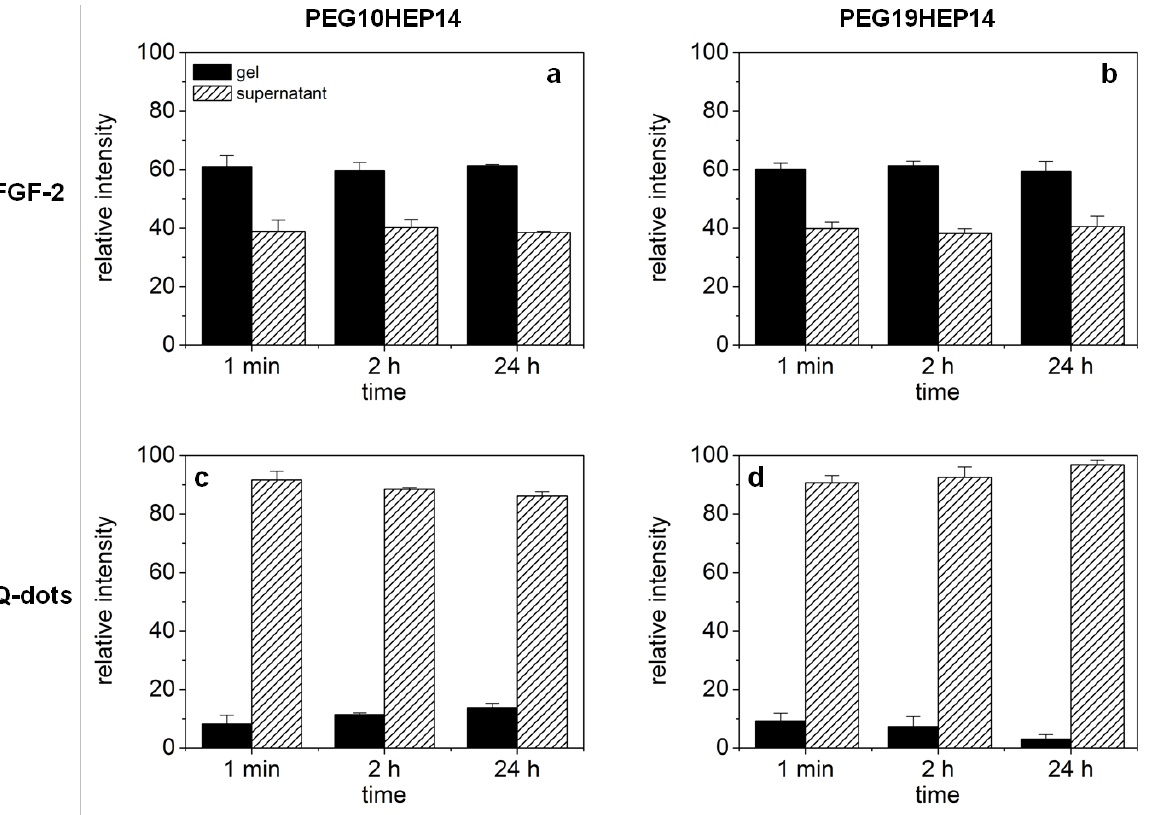
Figure 4. Average fluorescence intensity of TAMRA-labeled FGF-2 (top) and non targeted quantum dots (bottom) in supernatant (solution) and in the starPEG-heparin hydrogel body. Shown are mean values ± SD for hydrogels with a starPEG to heparin ratio of 3 containing starPEG M = 10,000 g/mol (left) or starPEG M = 19,000 g/mol (right), respectively (n = 2, mean values represent average intensity over 3 z-lines in gel or supernatant). Measurements were performed by